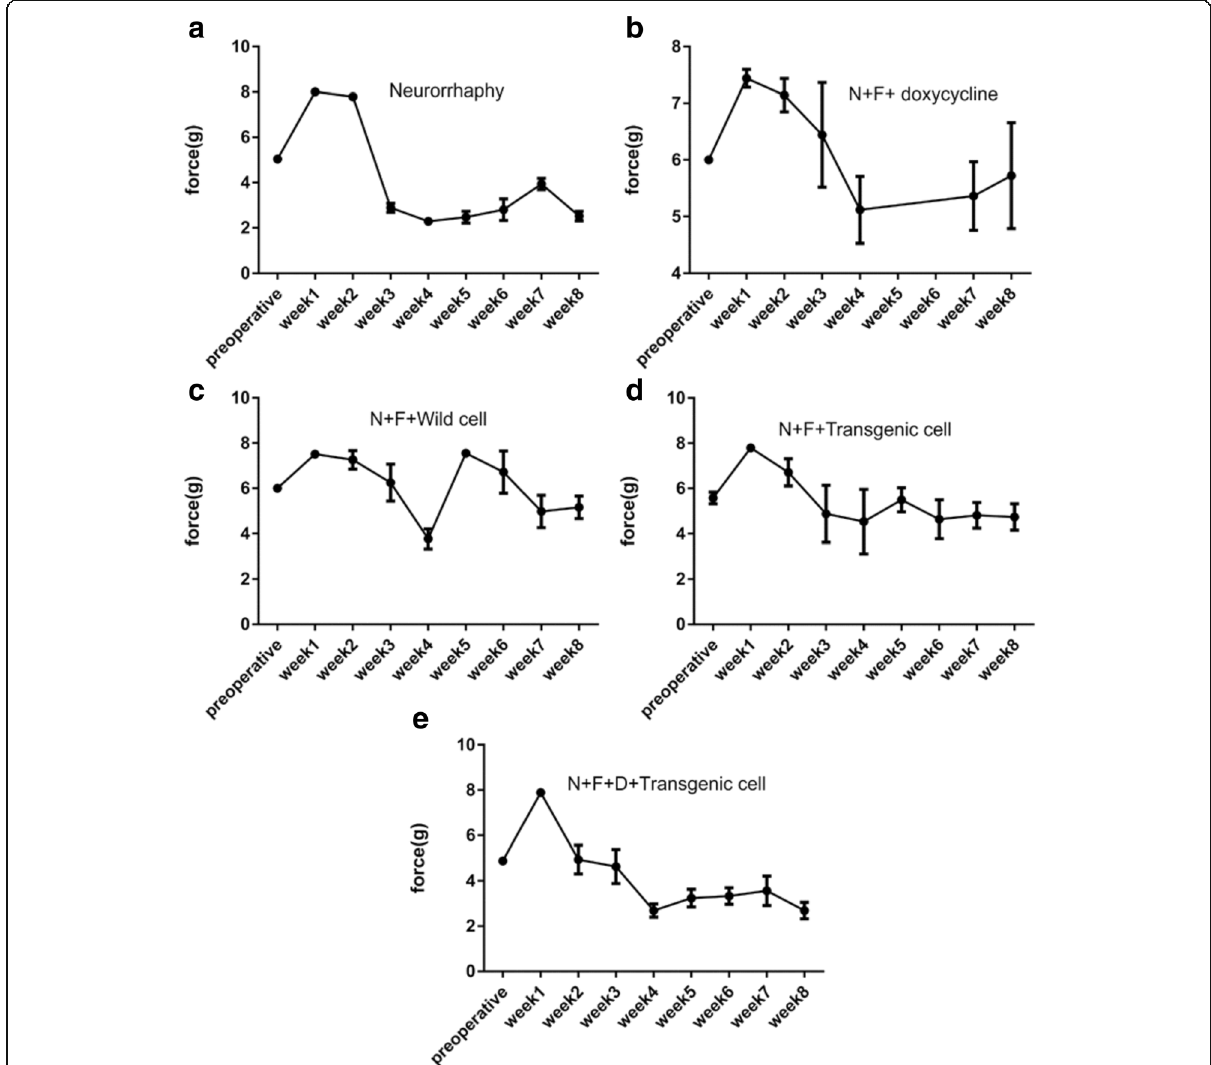
Fig. 8 The results of von Frey test for the following groups during eight weeks period. a Neurorrhaphy group. b Neurorrhaphy + heterologous fibrin sealant + doxycycline. c Neurorrhaphy + heterologous fibrin sealant + wild type hESCs. d Neurorrhaphy + heterologous fibrin sealant + transgenic cells (non-induced). e Neurorrhaphy + heterologous fibrin sealant + doxycycline + transgenic cells